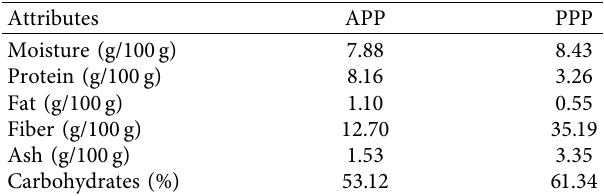
Table 4: Bioactive profile of apple pomace powder and pome- granate peel powder.